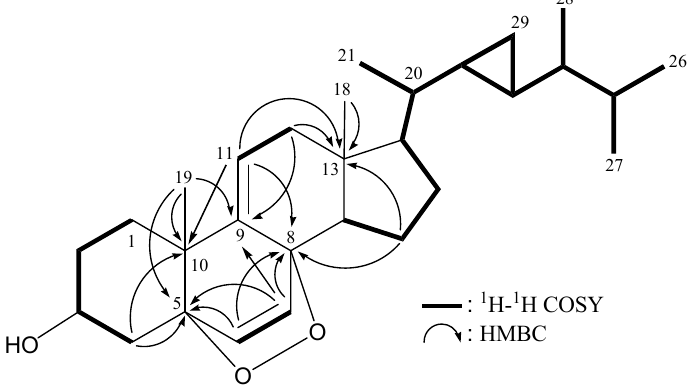
Figure 2. The 1 H– 1 H COSY and selective HMBC correlations (protons → quaternary carbons) for sterol 1